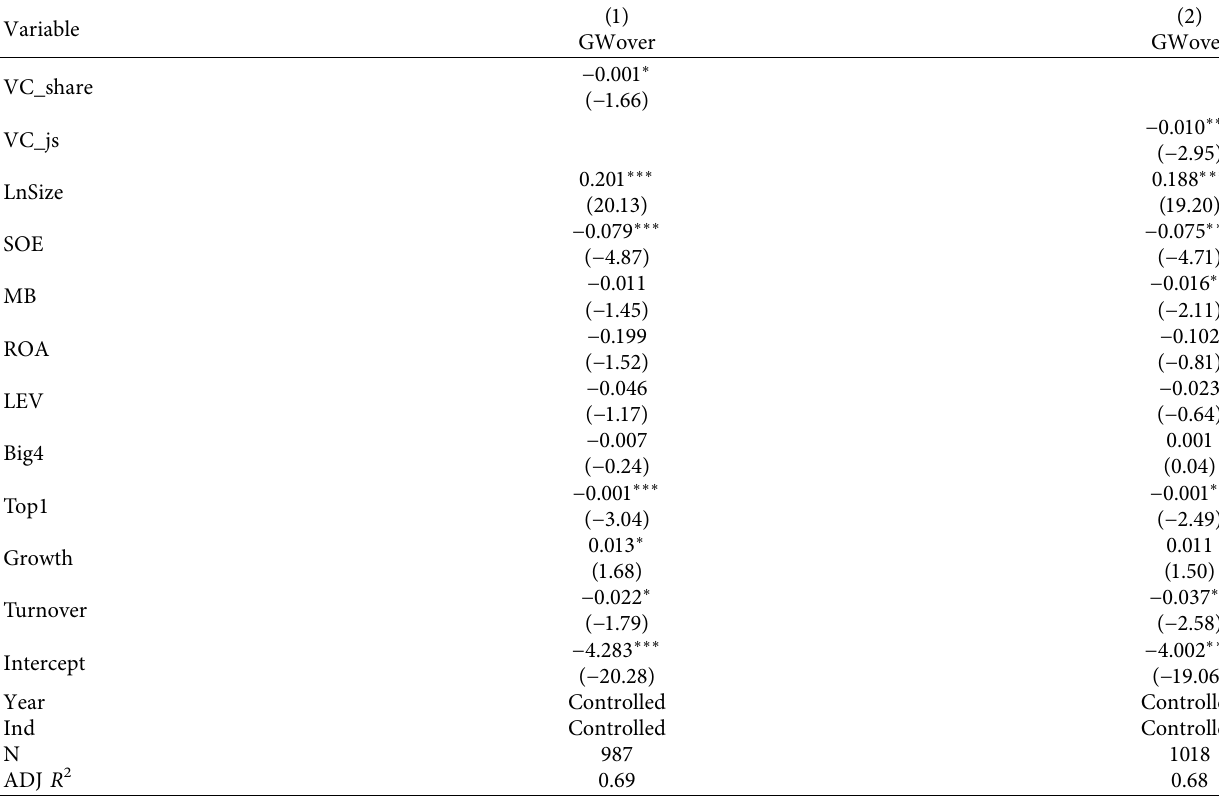
Table 13: Regression results of venture capital participation.